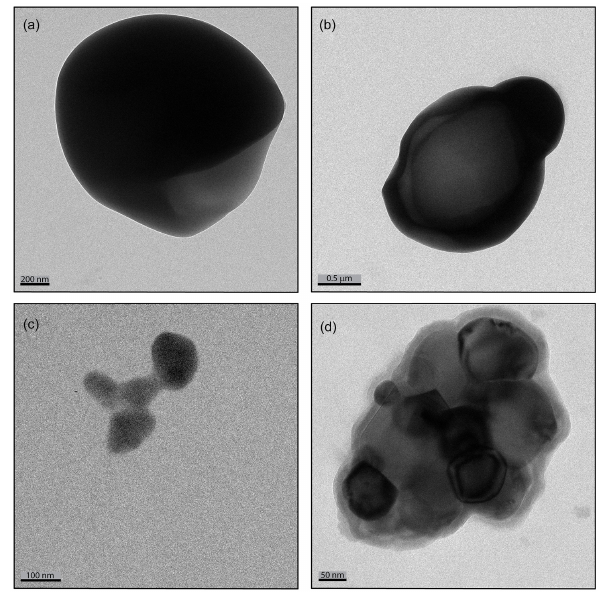
Figure 1. Transmission electron microscopy (TEM) images of typ- ical organic carbon “tar balls”, occurring as spheres and agglomer- ates, emitted from smoldering combustion of Alaskan and Siberian peat samples. The internal structure of these particles was amor- phous in nature. Electron dispersive spectroscopy (EDX) of tar balls shows that these particles consist primarily of carbon and oxygen with an average molar ratio between 6 and